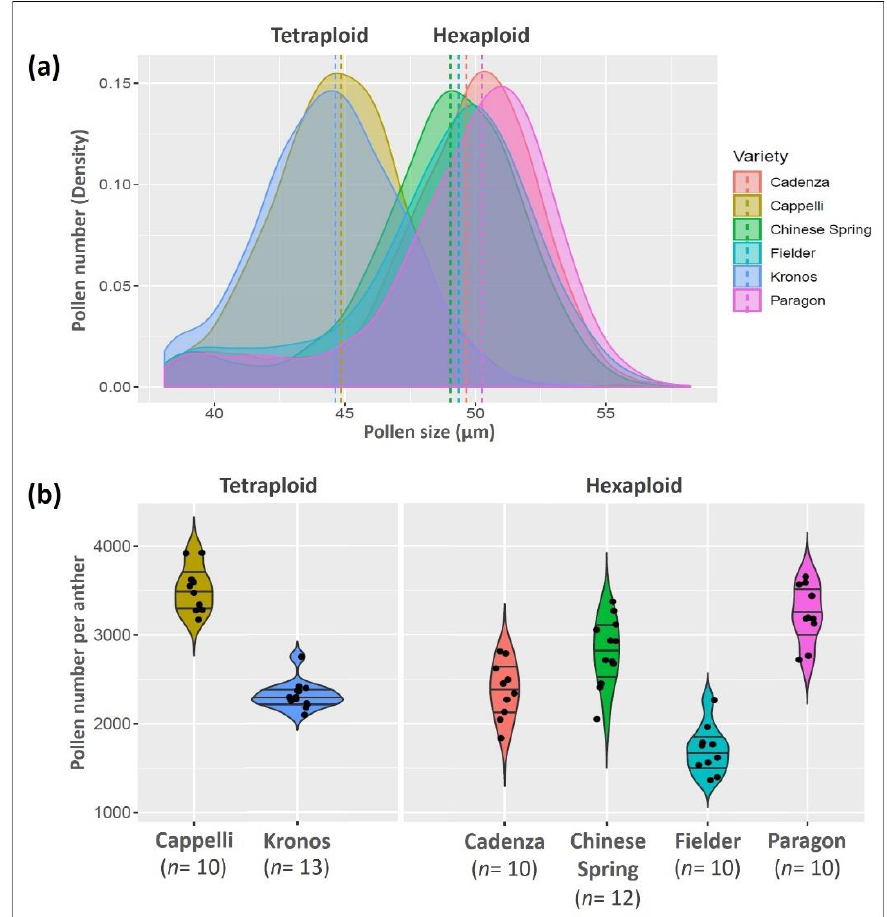
Figure 5. Pollen size and number per anther of some hexaploid and tetraploid wheats. ( a ) Density plot of the differential pollen size distribution data collected by coulter counter (Multisizer 4e) for four hexaploid wheats (Chinese Spring, Cadenza, Fielder and Paragon) and two tetraploid wheats (Cappelli and Kronos). Dotted lines indicate the median pollen grain size for each genotype. ( b ) Pollen number per anther for the six mentioned hexaploid and tetraploid wheat varieties. n is number of plants (biological replicates).